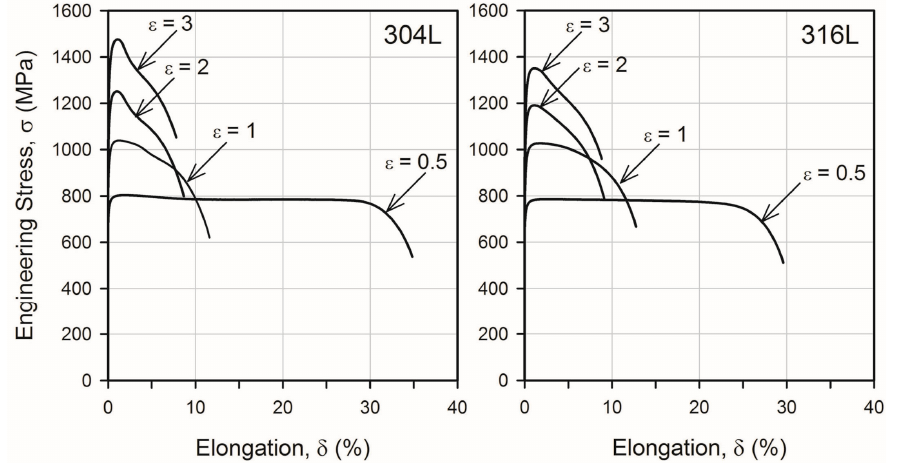
Figure 10. Engineering stress—elongation curves for 304L and 316L stainless steels subjected to rolling at 473 K to various total strains ( ε ) and then tensile tested at room temperature and at a crosshead rate of 2 mm/min.